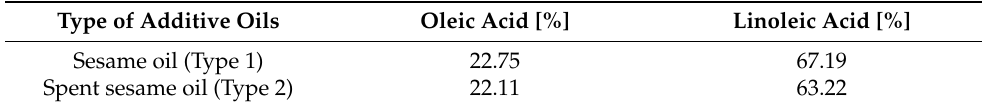
Table 2. Significant chemical characteristic of additive oils.